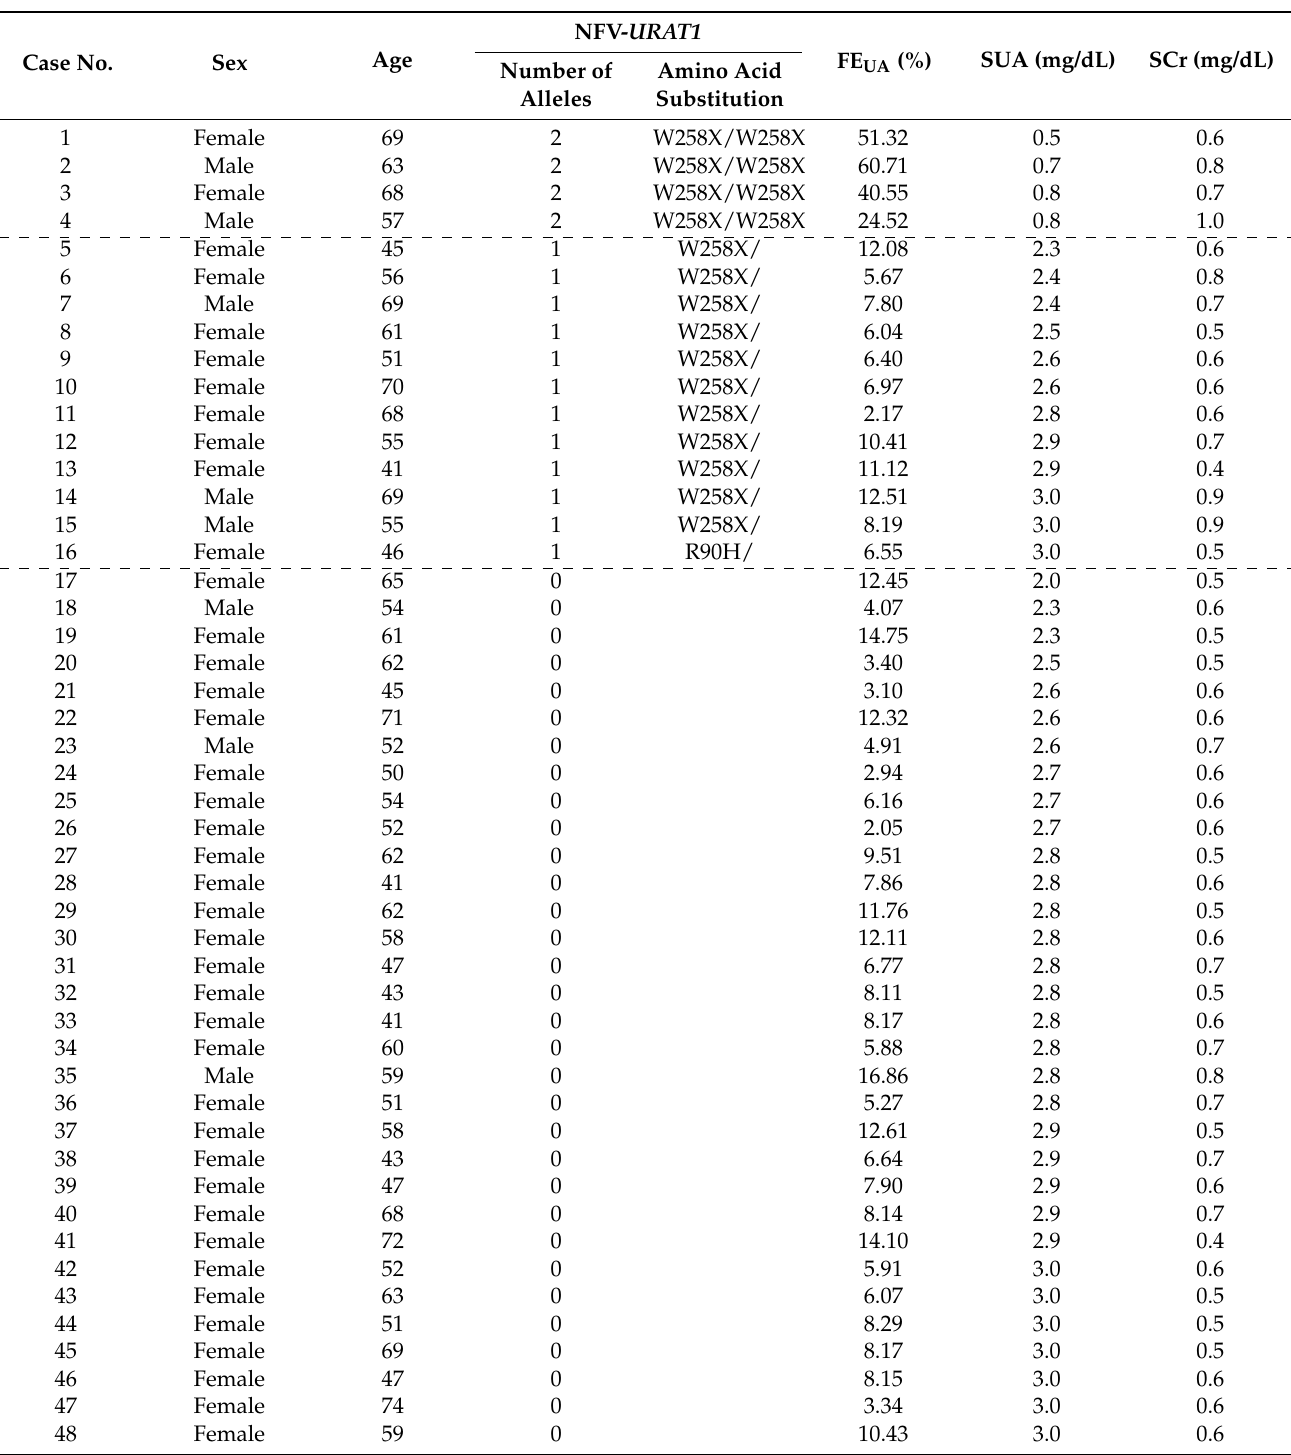
Table 4 shows laboratory data including FE UA , SUA levels and NFV- URAT1 of 52 hy- pouricemia and mild hypouricemia individuals (SUA ≤ 3.0 mg/dL) among those 2240 in- dividuals whose FE UA data were available (Figure 1). All four individuals (two males and two females) with two NFV- URAT1 alleles showed high FE UA (mean: 44.3%; range: 24.5–60.7%) and extremely low SUA levels of ≤ 1.0 mg/dL (severe hypouricemia). On the other hand, the other 48 individuals (6 males and 42 females) with one or no NFV- URAT1 alleles displayed a mean FE UA level of 8.01% (range: 2.05–16.86%). Most of them were mild hypouricemia (Table 4). Table 4. Laboratory data and NFV- URAT1 of 52 hypouricemic